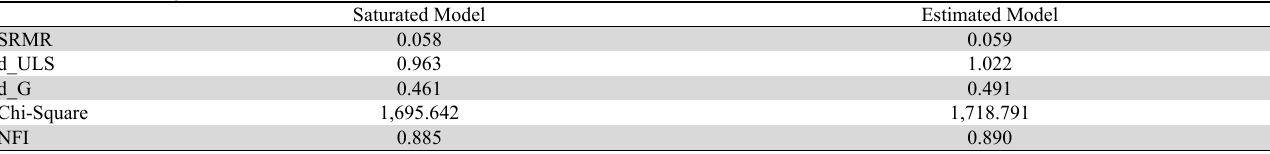
Fit Model Summary